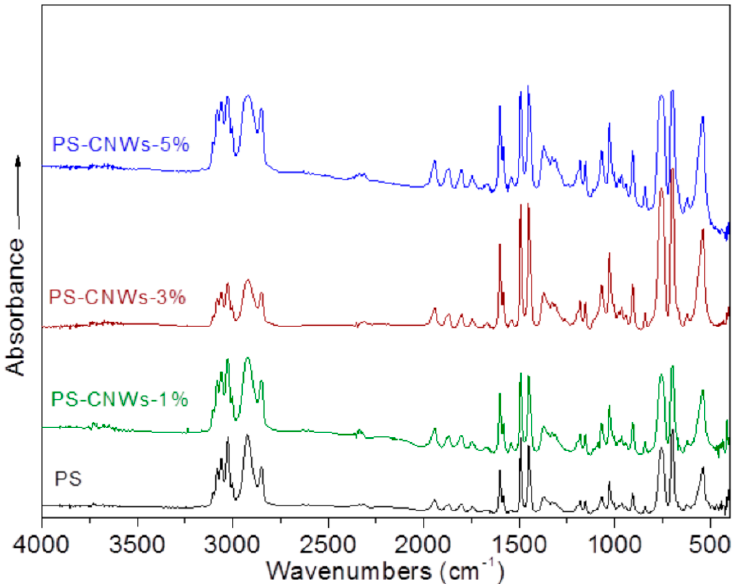
Figure 4. Images from atomic force microscopy (AFM) of the CNWs sample (right) and its topographical profile in ( a , b ).